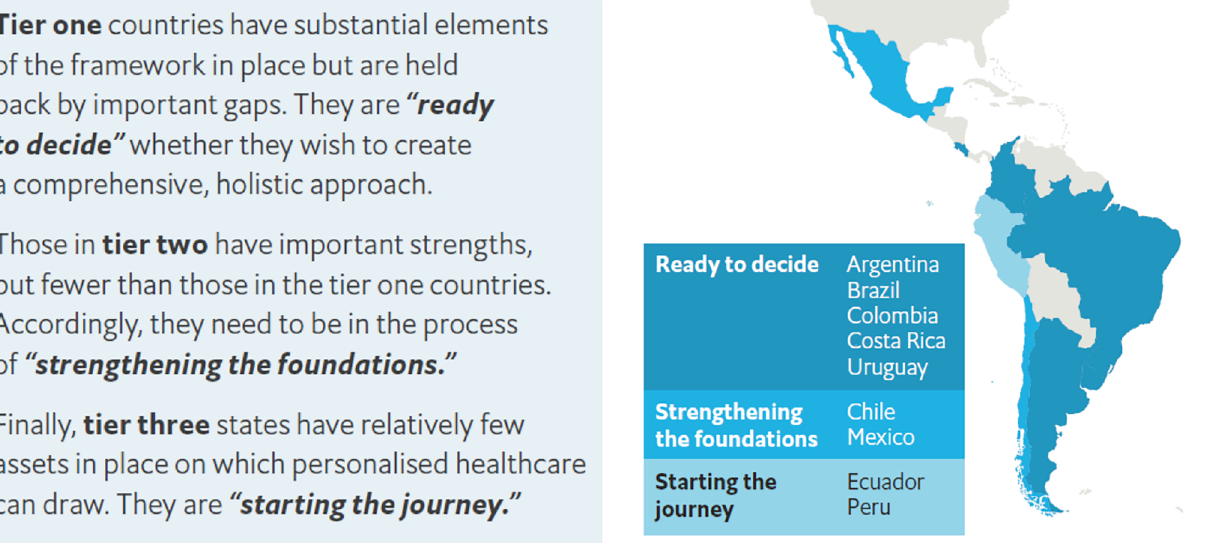
Figure 1. Definition of the categories used by “The Economist Intelligence Unit” to group Latin American countries as to the “willingness” to adopt personalized medicine and classification of each country according to the analysis.